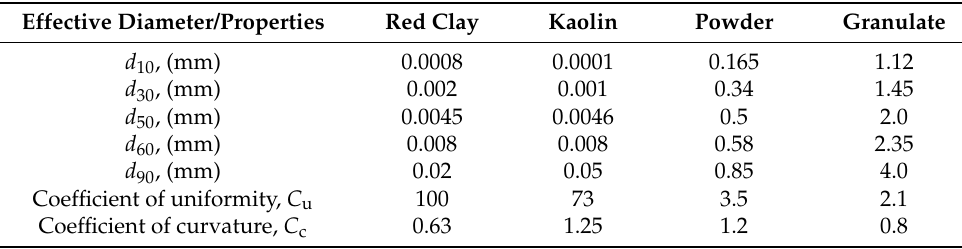
Table 1. Physical properties of the red clay (siCl/CH), kaolin (siCl/CL), powder (P), and granulate (G), based on the grain size distribution curves [30,53,64,70].